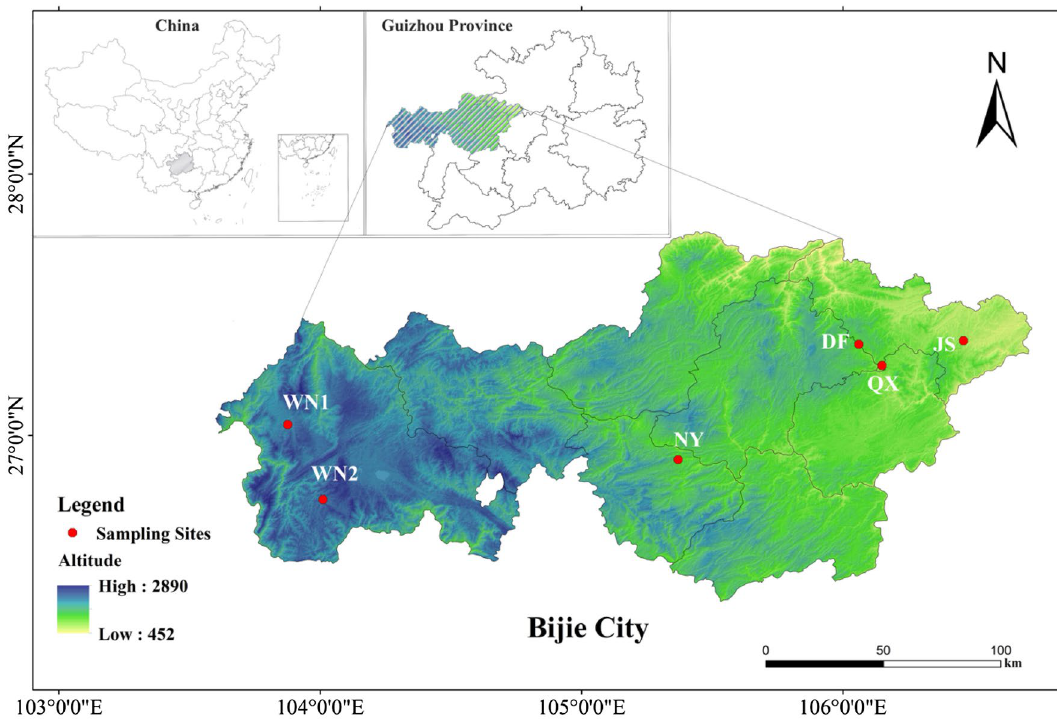
Figure 1. The location of sampling sites in Bijie City, Guizhou Province, China.WN1,2: Wei Ning1,2; NY: Na Yong; DF: Da Fang; QX: Qian Xi; JS: Jin Sha.